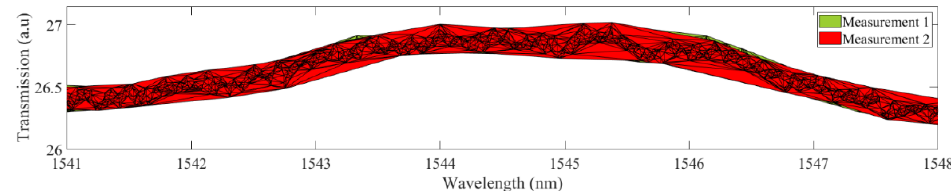
Figure 10. Higher cladding resonance peaks of TFBG transmission spectra after D-triangulation us-